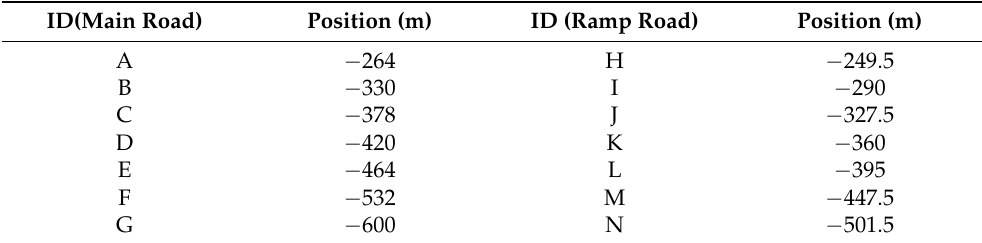
Table 2. The parameters of the vehicles for case study 1.